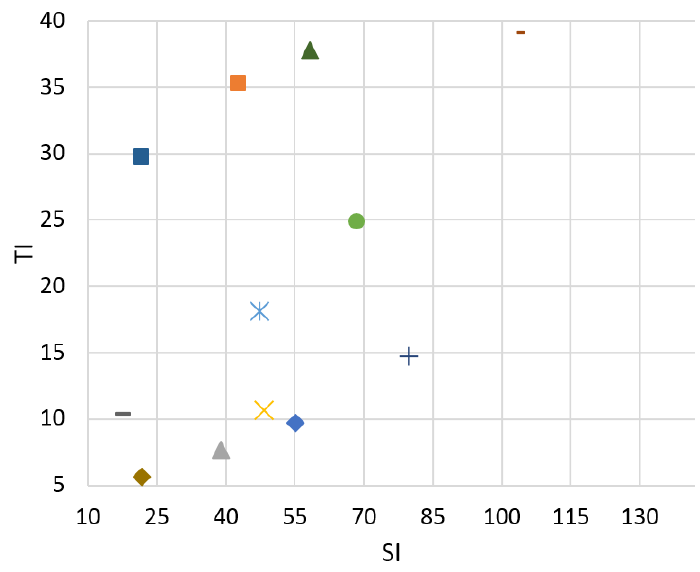
Figure 5. Ultra HD, H.265, bitrate 20 Mbps.